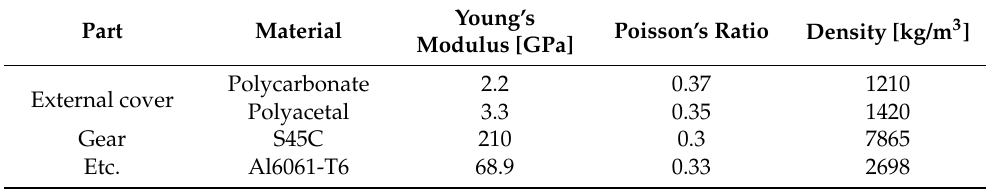
Table 4. Material properties.